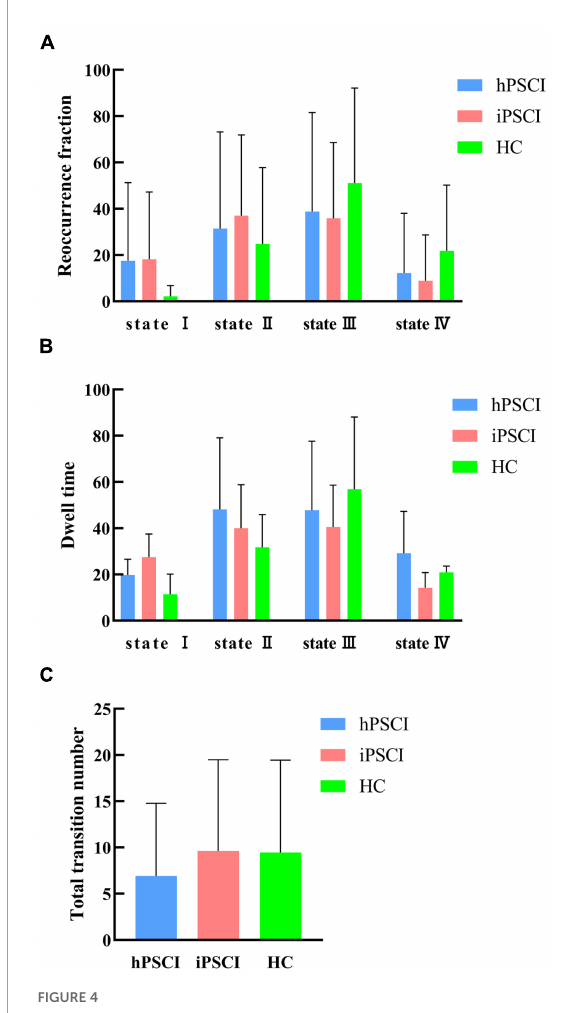
FIGURE4 Temporal properties of dFNC states for the three groups. (A) Reoccurrence fraction; (B) dwell time; (C) number of transitions. The error bars represent standard deviation; hPSCI, cognitive impairment group after hemorrhagic stroke; iPSCI, the cognitive impairment group after ischemic stroke; HC, health control